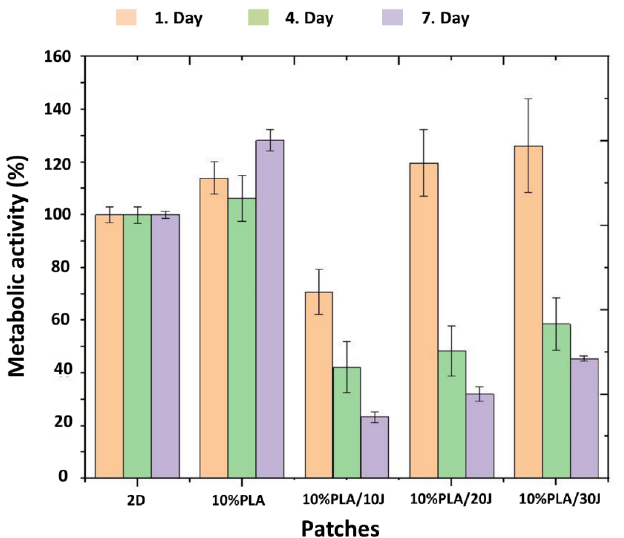
Figure 7. The MTT graph of the 2D (fibroblast cell line) and cells with scaffolds after 1, 4, and 7 days of